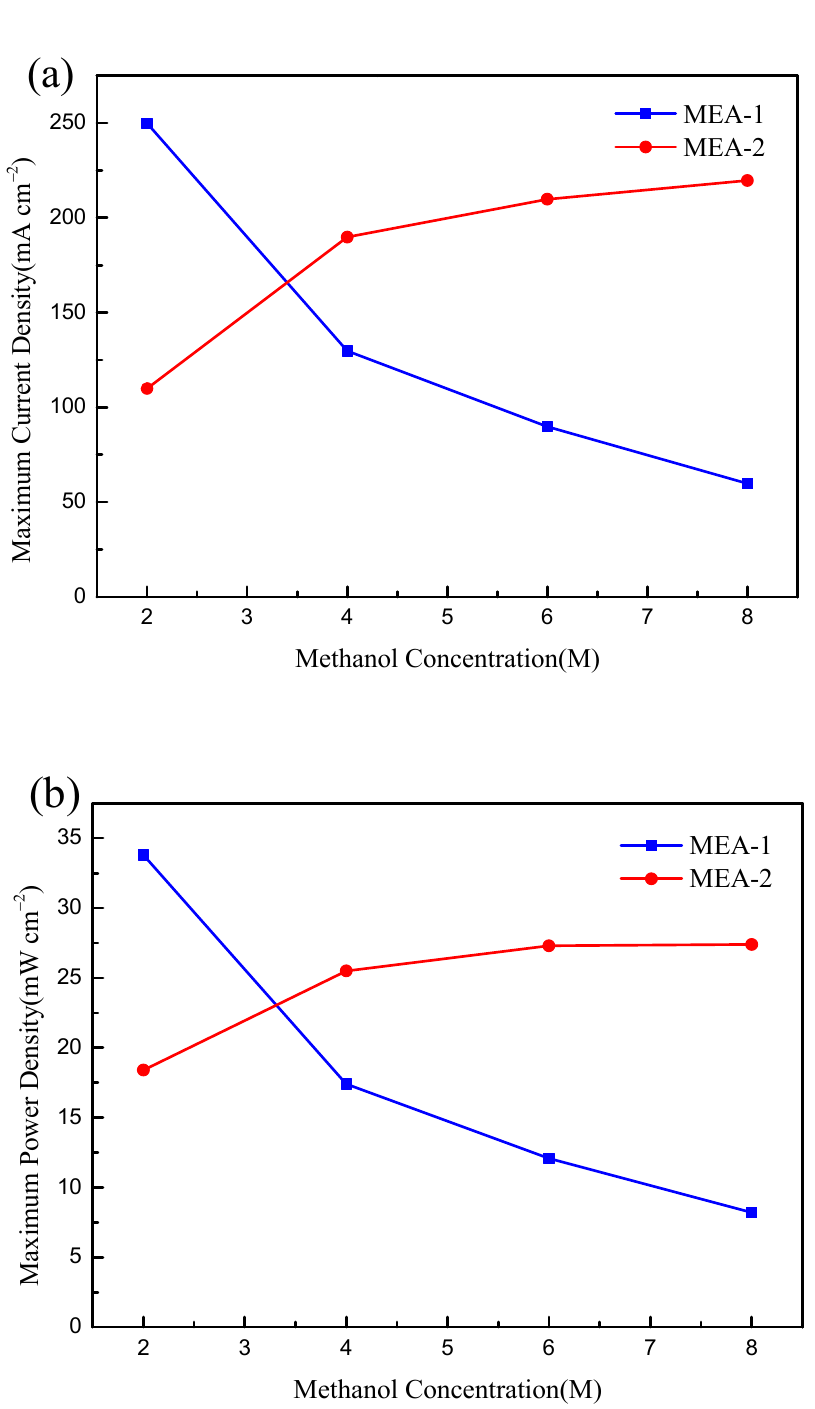
Figure 4. Comparison of maximum current density and maximum power density of ( a ) conventional electrodes and ( b ) novel electrodes at different concentrations.